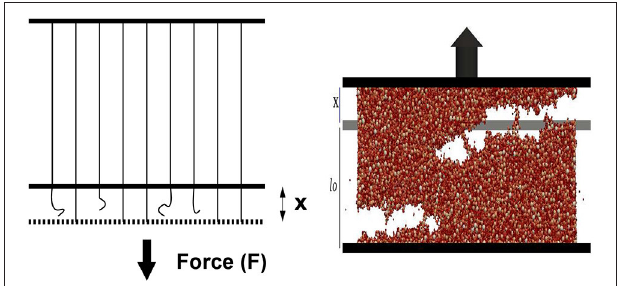
FIGURE 1 | (Left) the fiber bundle model—parallel fibers are placed between two rigid bars and are stretched by an amount x by applying a force F at the lower bar. (Right) The discrete element model—a thin tissue built of interconnected spherical particles vertically stretched using a constant velocity. The initial length of the fibers (left) and the initial height of the tissue are also